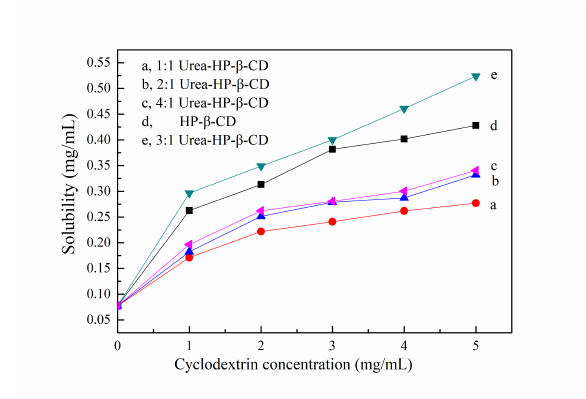
Fig.6. Phase solubility curves of VA at different